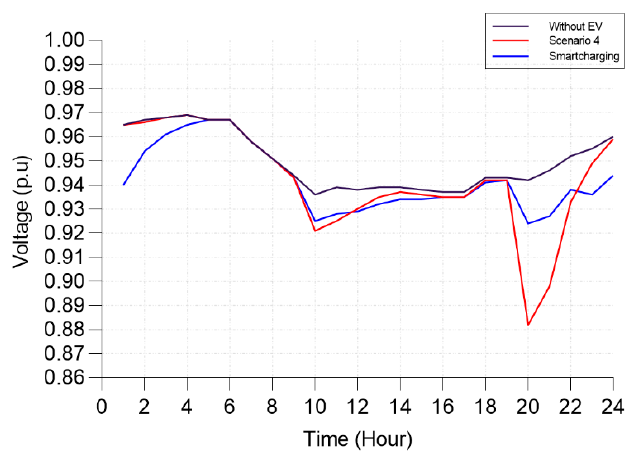
Figure 12. Voltage profiles, including with smart charging.